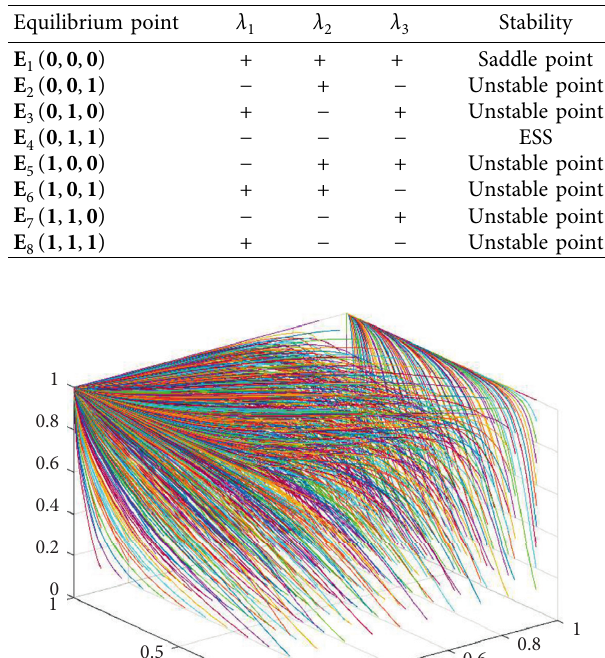
Table 5: Equilibrium point stability.